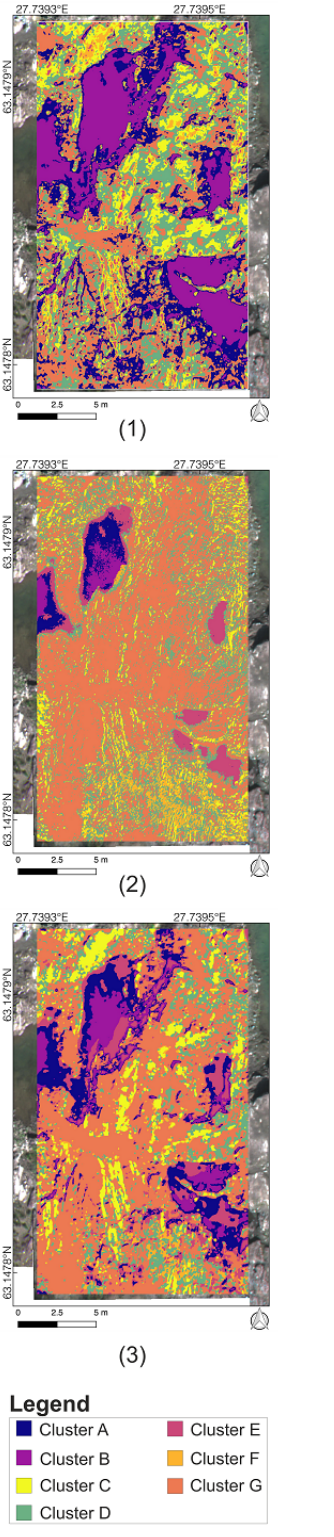
Figure 5. The clustering results obtained by (1) K-means, (2) Figure 4. The clustering results obtained by (1) K-means, (2) ESC, and (3) the proposed subspace-based HMRF algorithm on ESC, and (3) the proposed subspace-based HMRF algorithm on Scene No.2 (No. clusters:6). Class labels can be geologically Scene No.1 (No. clusters:7). Class labels can be geologically interpreted as follows, which cluster A: dark soil 1, cluster B: interpreted as follows, which cluster A: water 1, cluster B: water dark soil 2, cluster C: Carbonatite, cluster D: Glimmerite and 2, cluster C: Carbonatite, cluster D: vegetation and dark rock, soil, cluster E: Glimmerite, cluster F: vegetation and cluster E: shade and clay, cluster F: Glimmerite and soil, cluster G: host rock